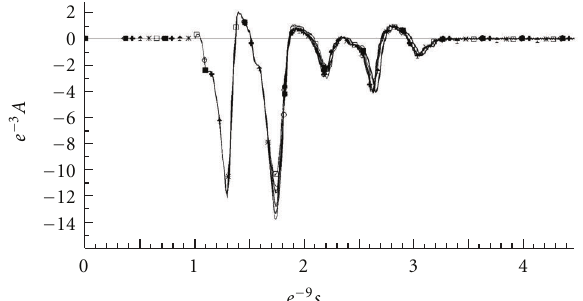
Figure 10: Current profiles of the DES submodule block imple- mented on the secure FPGA.